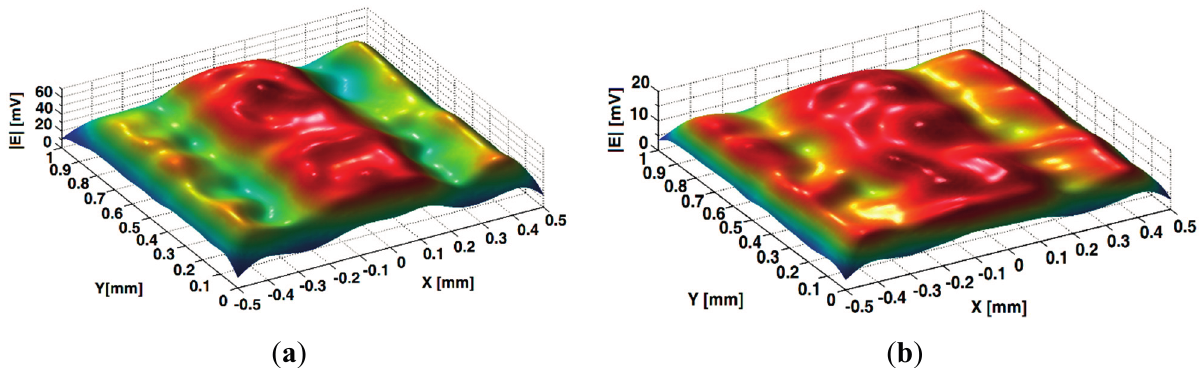
Figure 5. Image of evanescent and abnormal modes generated in slits for TMz polarized excitation at frequency of 476 MHz: ( a ) slits filled with air; ( b ) slits filled with isopropyl